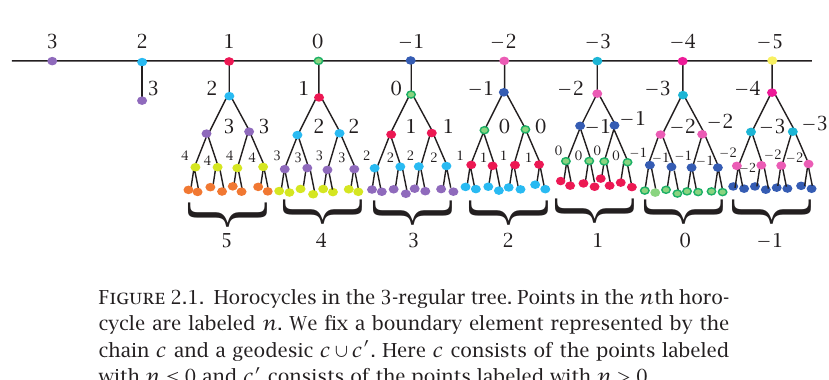
Figure 2.1 . Horocycles in the 3-regular tree. Points in the n th horo- cycle are labeled n . We fix a boundary element represented by the chain c and a geodesic c ∪ c (cid:5) . Here c consists of the points labeled with n ≤ 0 and c (cid:5) consists of the points labeled with n >